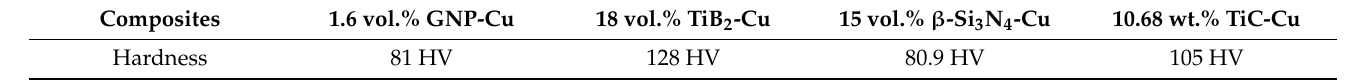
Table 1. Properties parameters of the reinforcement copper matrix composite